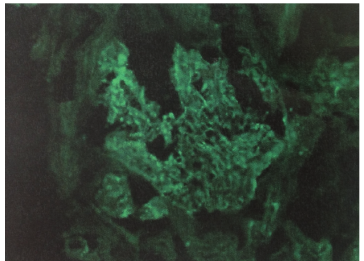
Figure 3: Direct immunofluorescence showing granular staining in capillary loops for IgG.